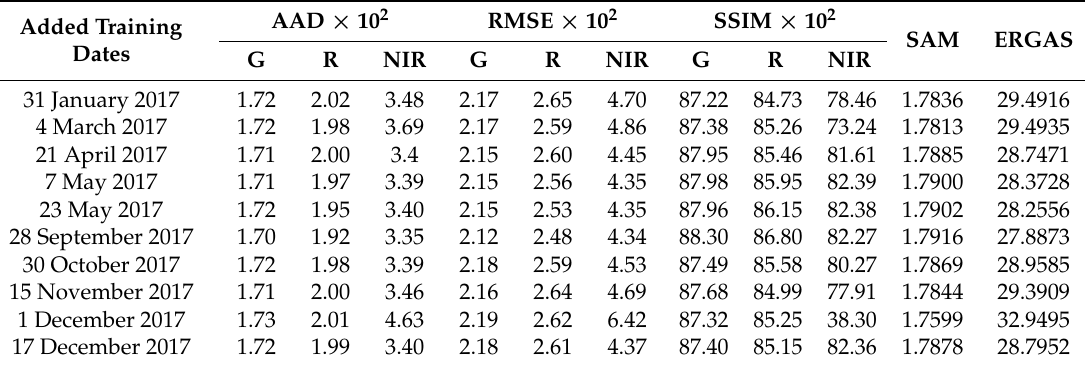
Table 8. Assessment indices from the proposed fusion with the urban data acquired in 2017 for modeling reflectance on 12 September 2017.